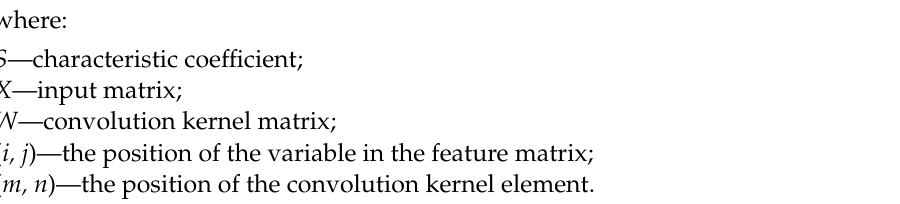
Figure 4. Diagram of convolutional neural network image recognition process.